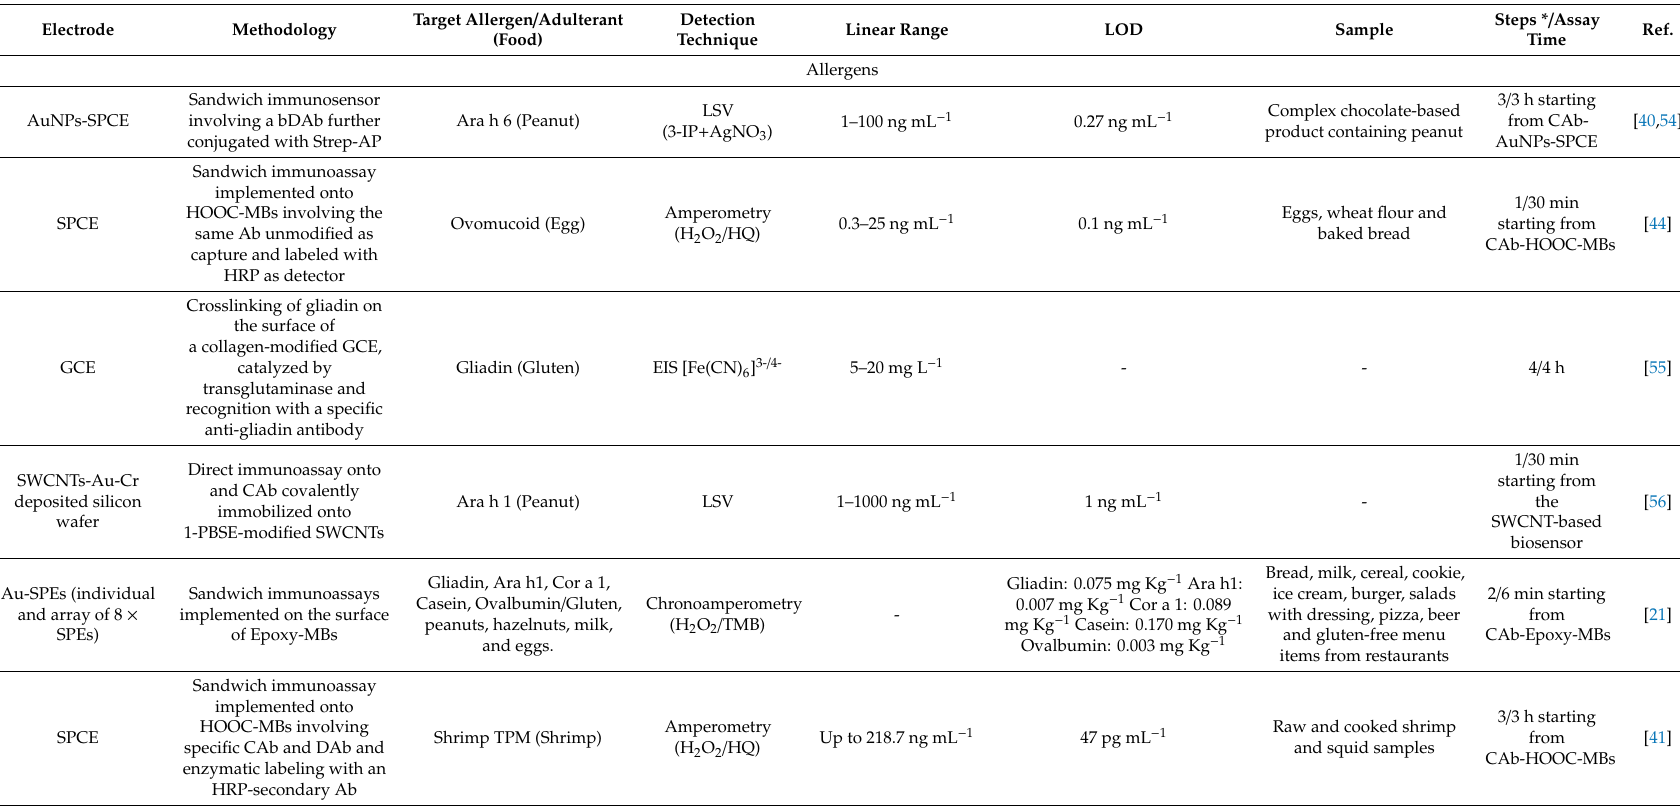
Table 1. Electrochemical immunosensing methodologies reported since 2017 for the determination of food allergens and